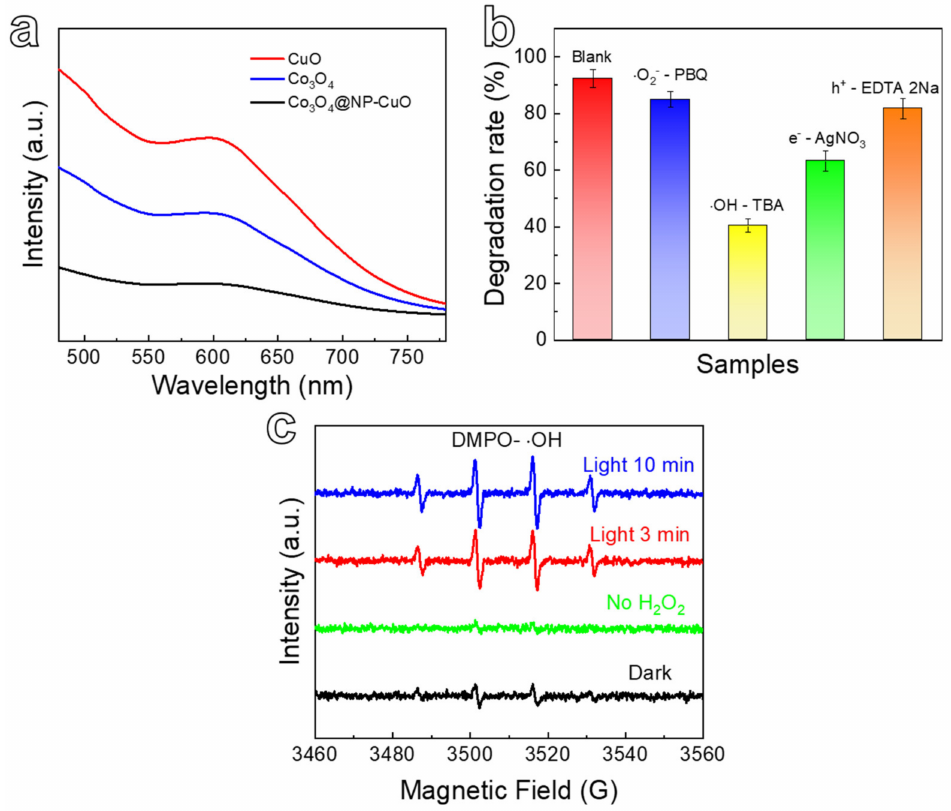
Figure 8. ( a ) PL spectra of Co 3 O 4 @NP-CuO, CuO, and Co 3 O 4 ; ( b ) Effect of different free radicals on photocatalytic degradation of Co 3 O 4 @NP-CuO; ( c ) EPR spectra of · OH generated under different conditions for the Co 3 O 4